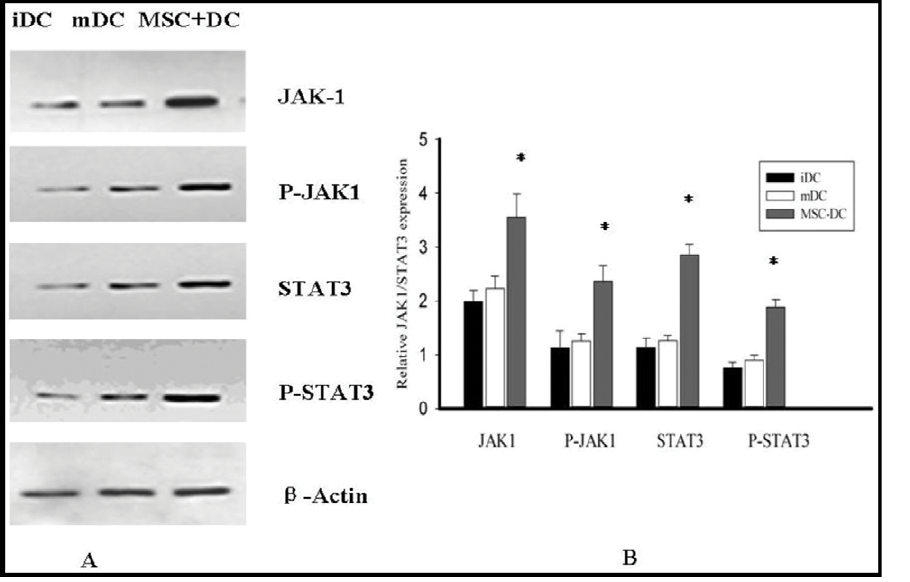
Figure 5. Protein expression of JAK1, P-JAK1, STAT3 and P-STAT3 in monocultures of iDCs, mDCs and in co-cultures of MSC-DC (MSC:DC ratio of 1:10). (A) Western Blot; (B) Quantification by image analysis of the protein expression. * P , 0.05 (MSC-DC group versus mDC